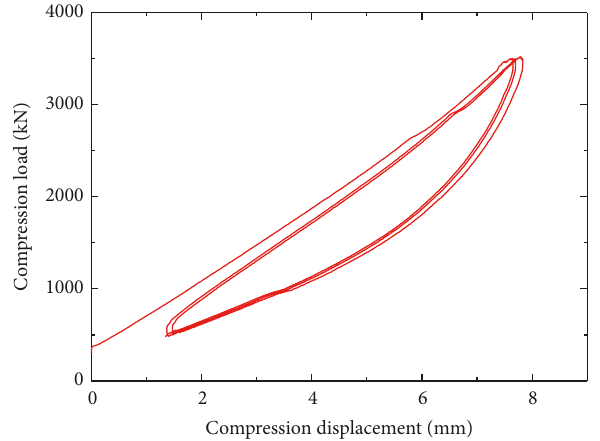
Figure 8: Compressive load-displacement curve under three-cyclic